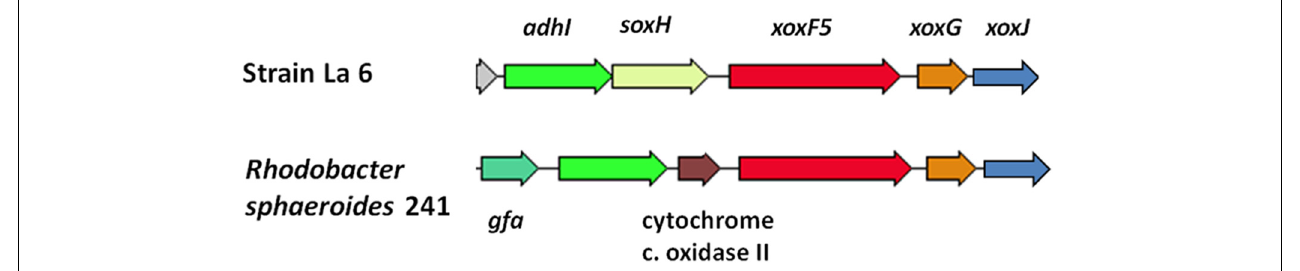
FIGURE 2 | Gene cluster surrounding the predicted methanol dehydrogenase gene xoxF5 and comparison to the methylotroph Rhodobacter sphaeroides 241. Colors indicate predicted similar functions of genes between the two organisms. adhI, glutathione-dependent formaldehyde dehydrogenase; soxH, putative protein